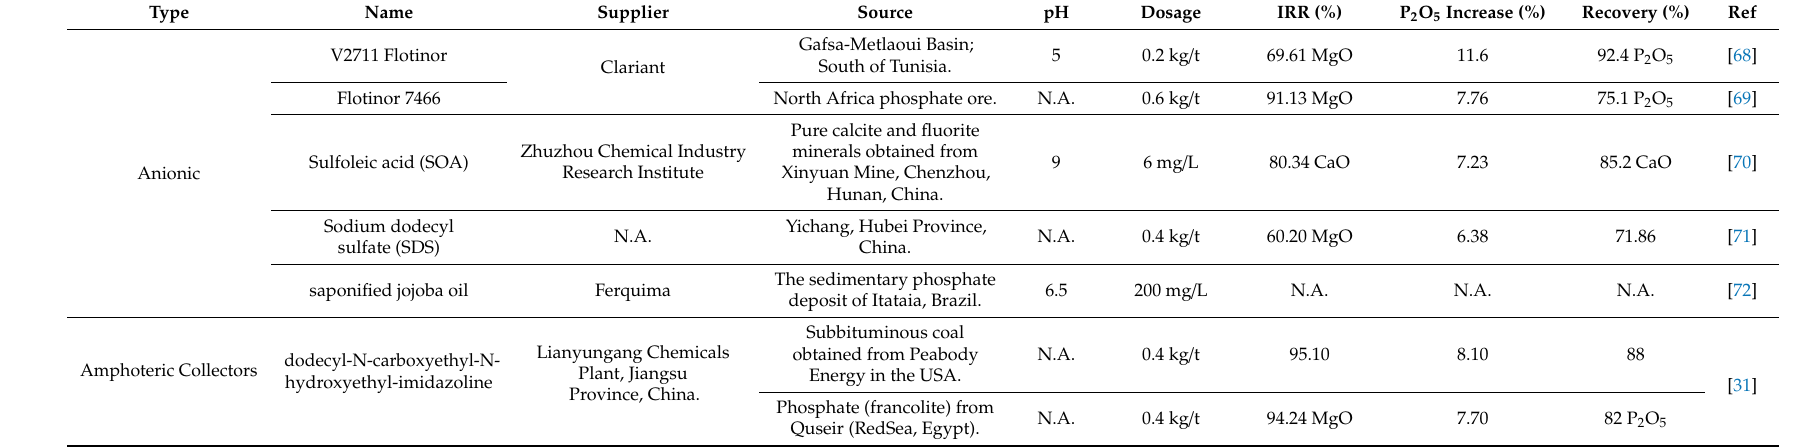
Table 10. Collectors used for the selective flotation of carbonates (calcite and